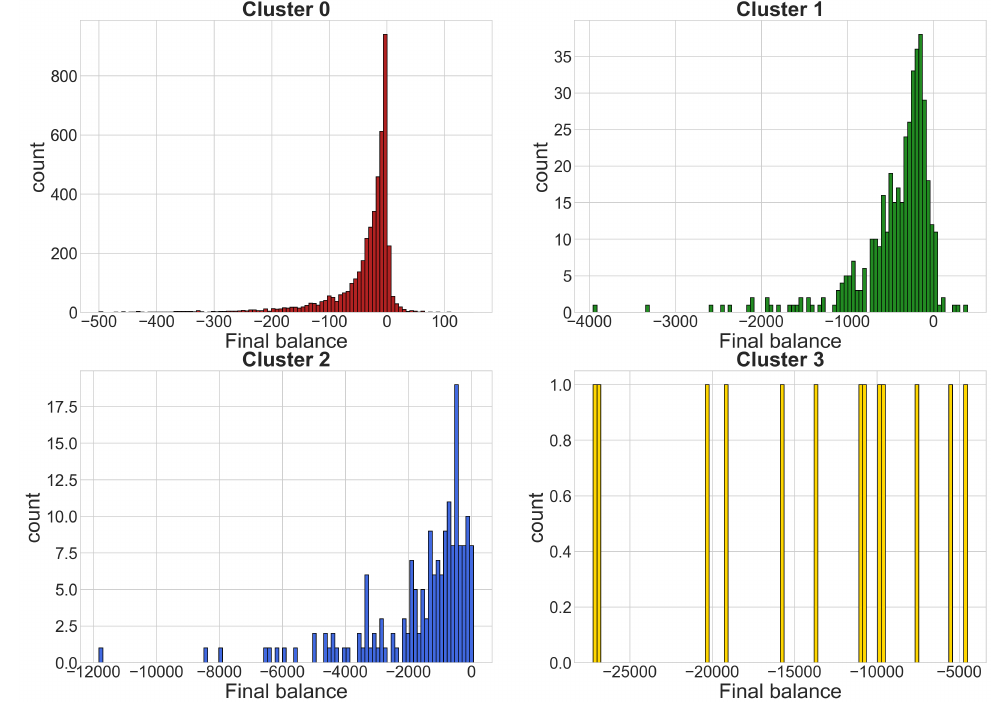
Figure 17. Histograms of the total balance obtained using the time series k -means algorithm. The x axis reports the balance, while the y axis shows the number of players that obtained that balance during the